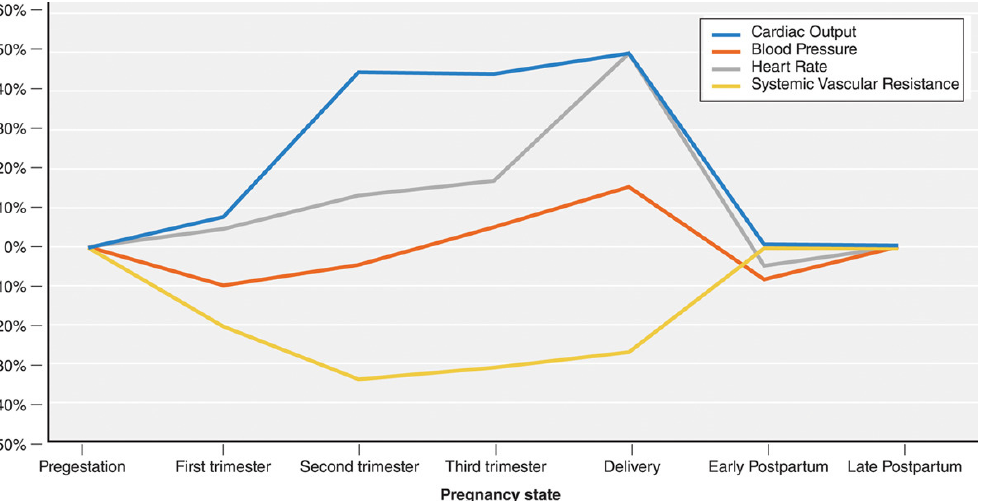
Figure 2. Physiologic changes during pregnancy. Mehta et al. Cardiovascular considerations in caring for pregnant patients, Circulation 2020 [7].